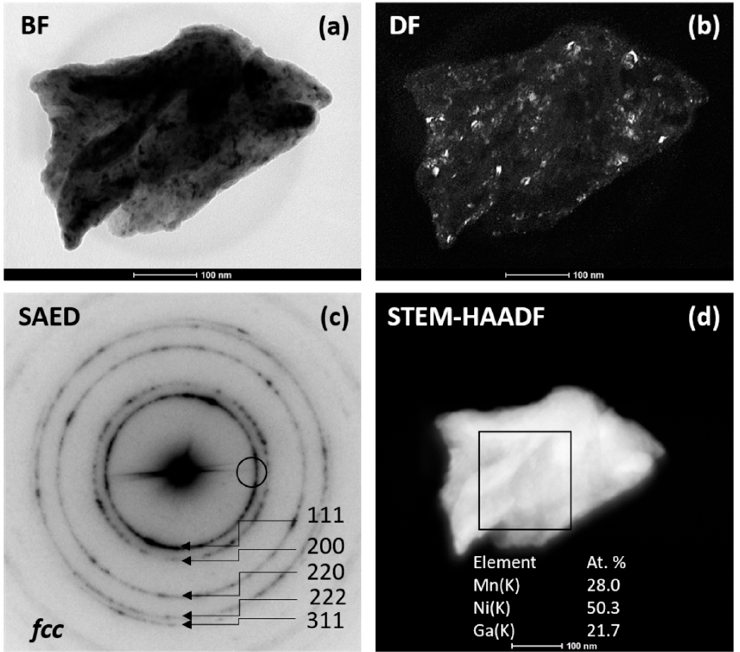
Figure 2. TEM bright field ( a ), dark field ( b ), selected area electron diffraction ( c ), and STEM-HAADF ( d ) images taken at room temperature from the powders after 8 h milling.